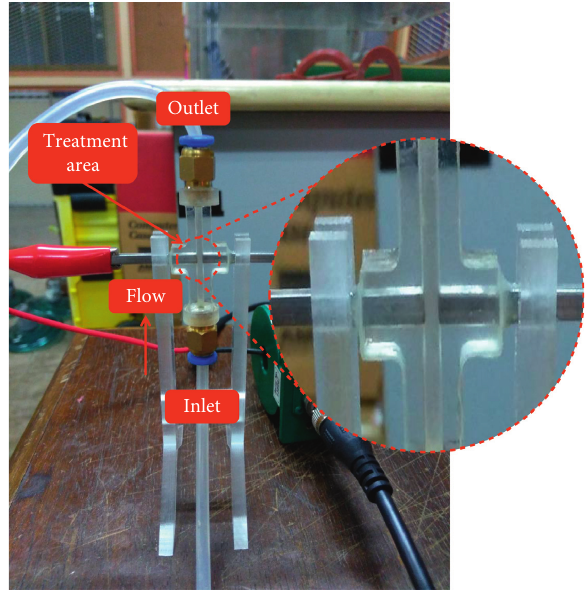
Figure 5: Parallel electrode treatment chamber in continuous type. The flow begins from bottom to top and is influenced by gravity